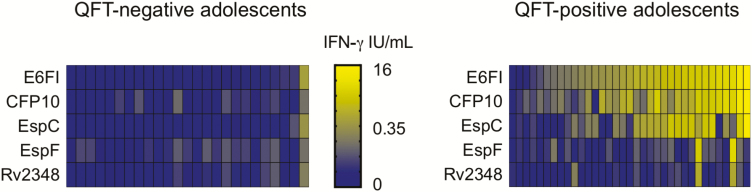
Early secretory antigenic target-6–free IFN-γ release assay antigen recognition by South African adolescents. Heat map of log10(IFN-γ) showing recognition patterns of all antigens in each QFT-negative (left) and QFT-positive (right) participant. In the absence of a cutoff to define recognition of each E6FI antigen, log10(IFN-γ) are presented on a continuous quantitative scale. Abbreviations: IFN-γ, interferon-gamma; QFT, QuantiFERON-TB Gold In-tube.